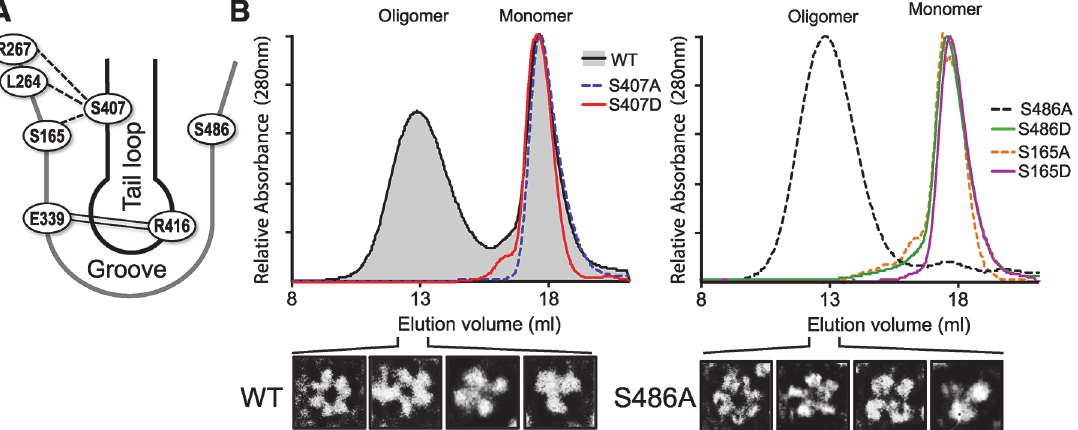
Fig 4. S407 and S486 are located at the NP:NP interface and influence oligomerization. (A) Schematic representation of the NP:NP interface highlighting the organization of S407 in the tail loop of one protomer and S486 and S165 in the binding groove of the binding partner. The salt bridge interaction between R416 and E339 is shown by double line. The crystal structure of NP suggests potential intermolecular H-bonding between S407 of the tail loop and residues S165, S264 and S267 in the groove, indicated by dotted lines [13]. (B) RNA-free WT, mutant, and phosphomimetic NP were purified from bacteria and analyzed by size exclusion chromatography. NP monomer and oligomer peaks are marked. Heterogeneity within the oligomeric WT and NP S486A populations was detected by negative stain electron microscopy, revealing NP trimers, tetramers, pentamers and